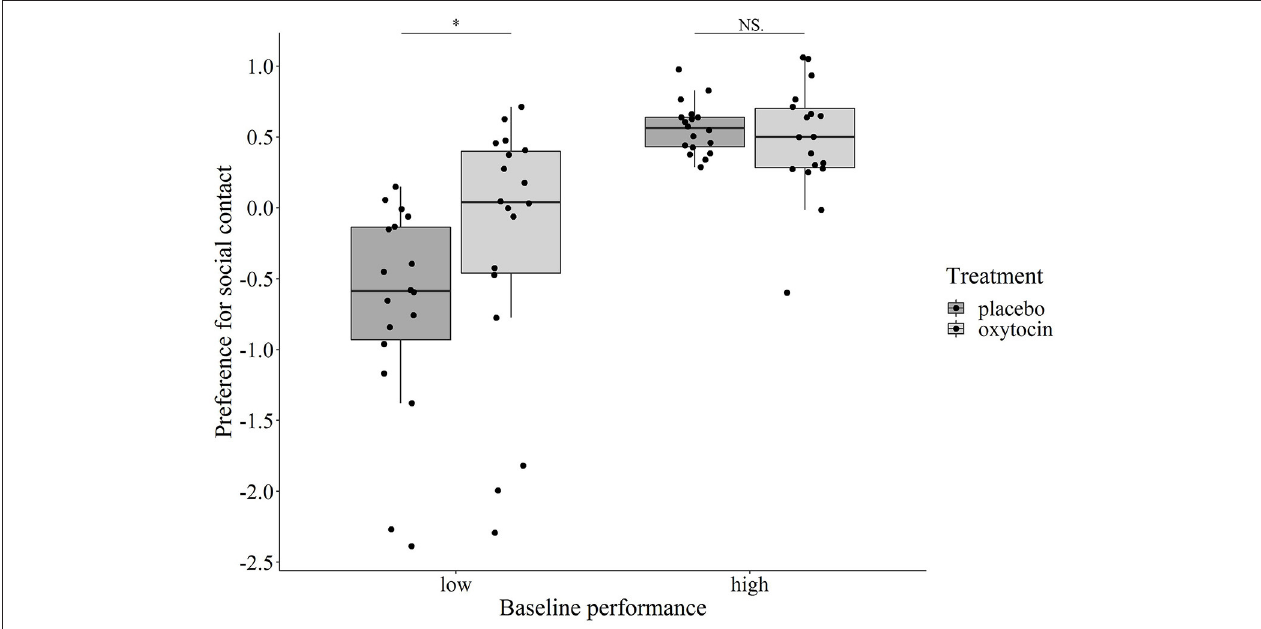
FIGURE 3 | Relationship between the dogs’ baseline performance and oxytocin/placebo treatment on their Preference for social contact component score. Oxytocin treatment significantly increased the component score in dogs with low baseline performance (* p = 0.004), while the effect of treatment was not significant in dogs with high baseline performance ( p =